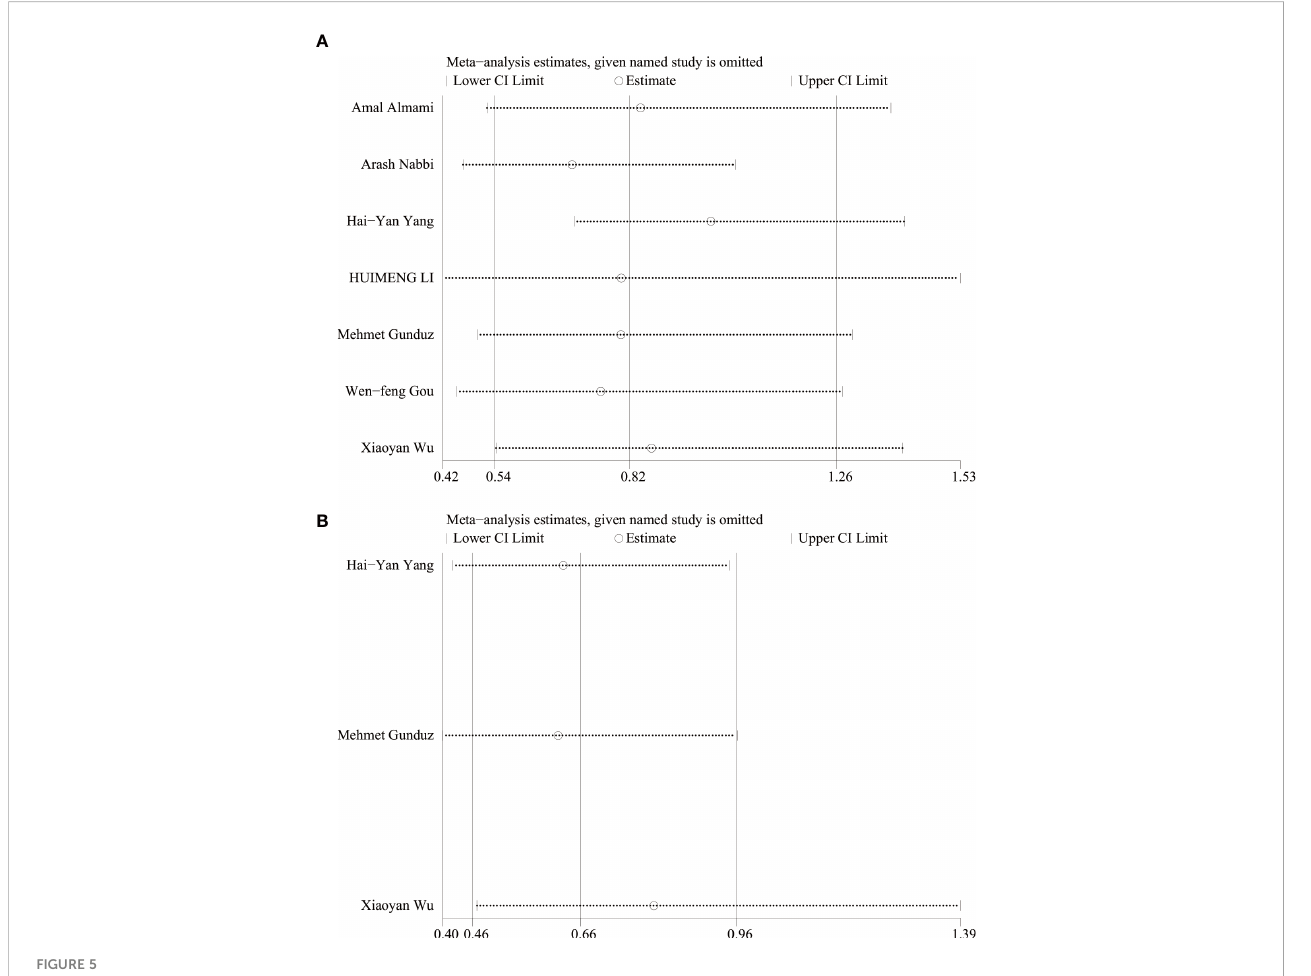
FIGURE 5 Sensitivity of systematic review and meta-analysis of OS (A) and DFS (B)